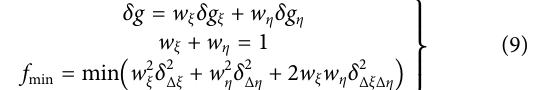
Frontiers in Earth Science |